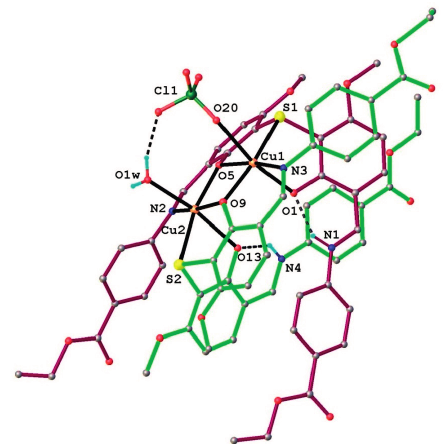
Figure 6. The X-ray structure of the complex cation [Cu 2 (L 2 S) 2 (ClO 4 )(H 2 O)] + ( 6 ). H-bonds